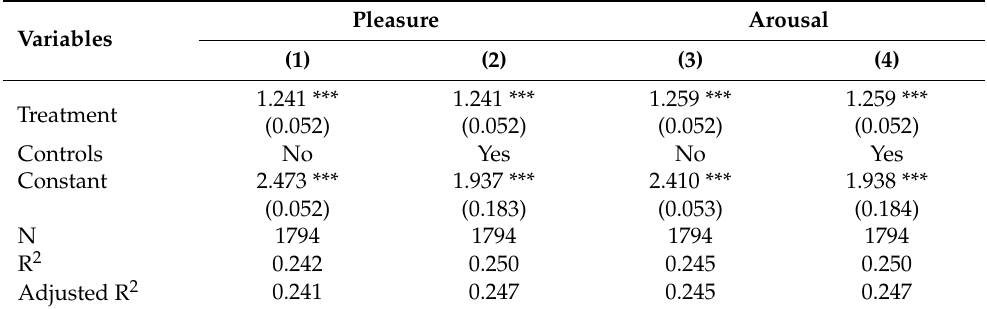
Table A8. The effect of culture and leisure walking streets on tourists’ pleasure and arousal.